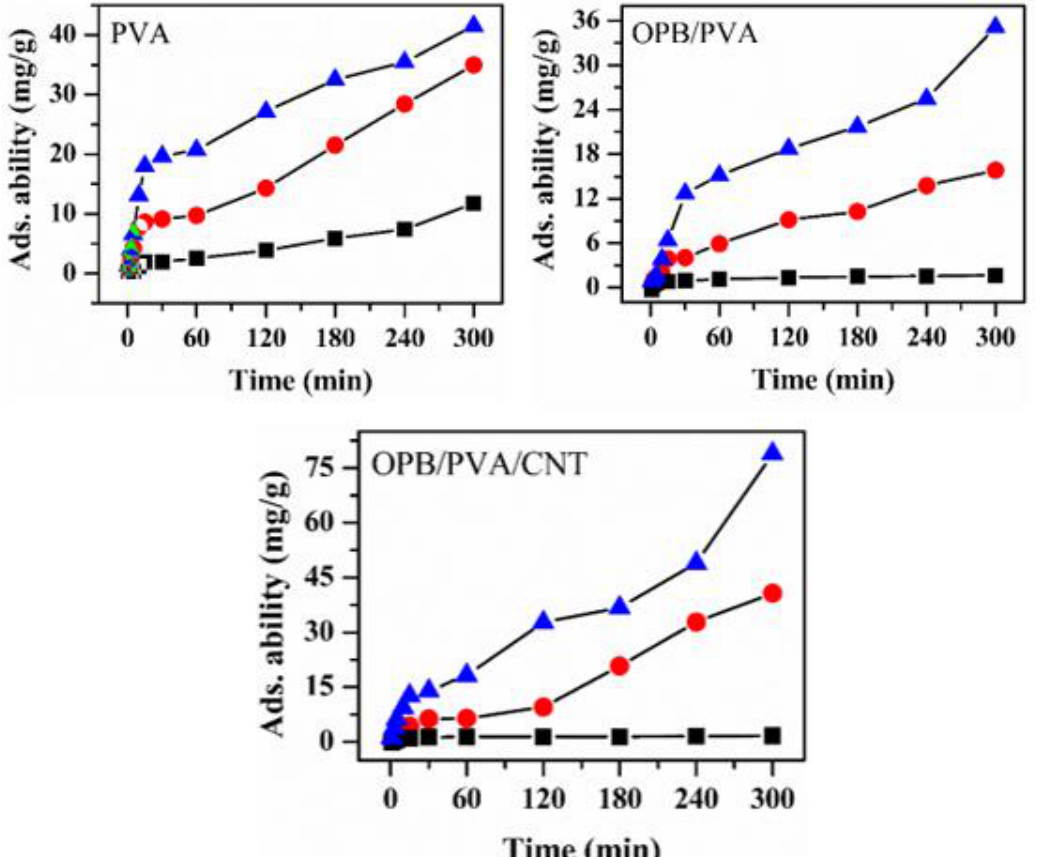
Figure 10. Effect of initial concentrations (65, 150 and 200 mg/L) for the adsorption of Pb(II) onto the PVA, OPB/PVA and OPB/PVA/MWCNTs hydrogel adsorbents. Experimental conditions: adsorbent dose = 0.5 g and pH = 7 and maximum adsorption time = 300 min (1, 3, 5, 10, 20, 30, 60, 120, 180, 240 and 300 min) at room temperature.